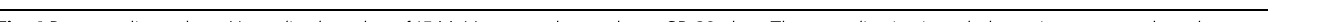
Fig. 4 Proton radiography. a Normalized number of 15 MeV protons detected on a CR-39 plate. The normalization is such that unity corresponds to the mean number of protons per pixel on the detector. The D 3 He capsule was imploded at t = 29ns. Fusion reactions occur 0.6 ns after the start of the implosion and the protons are emitted isotropically within a short burst, of ~150 ps duration 39 . The fl ight time of the protons to the plasma is 0.1 ns. The chlorinated plastic foils were driven with a 10ns long pulse shape (see Fig. 1). X-ray data and FLASH simulations indicate that the plasma fl ows are close to collision by 29ns (see also Supplementary Figure 9 in Supplementary Methods). Thus, this proton image can provide an estimate of the initial seed fi elds. b Same as a , but with the deuterium – tritium capsule imploded at t = 34ns. The development of structures shows the development of fi elds in the interaction region. c Same as b , but with the chlorinated plastic foils driven with the 5ns long pulse, which gives higher fl ow velocities, and hence higher magnetic Reynolds numbers. d Reconstruction of magnetic fi elds for case a . e Reconstruction of magnetic fi elds for case b . f Reconstruction of magnetic fi elds for case c . g Power spectrum of the magnetic energy from the reconstructed magnetic fi eld from experimental data (the region bound by a dashed line in panel f